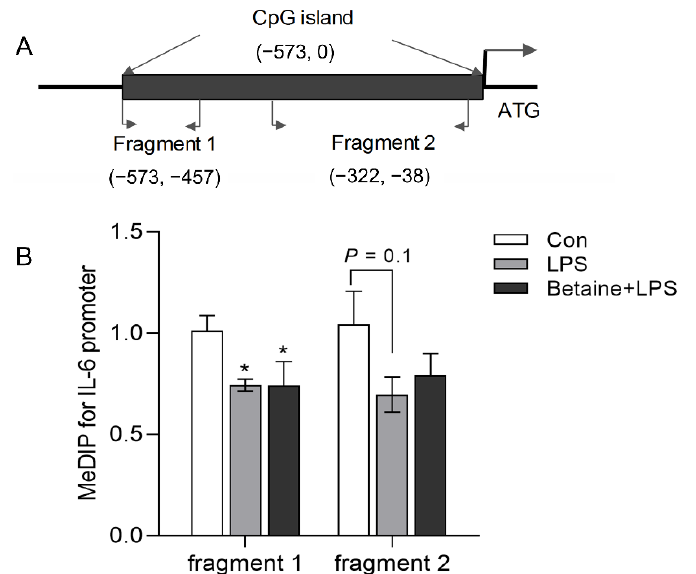
Figure 3. qRT-PCR quantification of the mRNA expression of DNA methylation-associated enzymes. The treatment and method were described in Figure 1 caption. Values are mean ± SEM, n = 6/group. Significance levels: * p < 0.05, ** p < 0.01 vs. control, # p < 0.05, ## p < 0.01 vs. LPS.